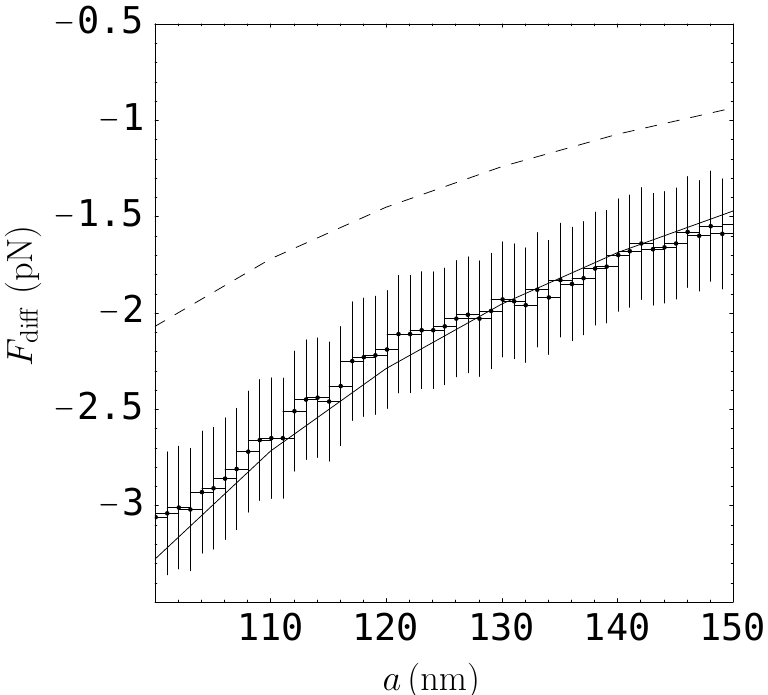
Figure 5. The differences in the Casimir forces between an Au-coated sphere and a silicon membrane in the metallic and dielectric states measured using an atomic force microscope [38] (crosses) com- pared with the theoretical predictions of Lifshitz theory obtained with omitted and included DC conductivity of Si in the dielectric state (solid and dashed lines,